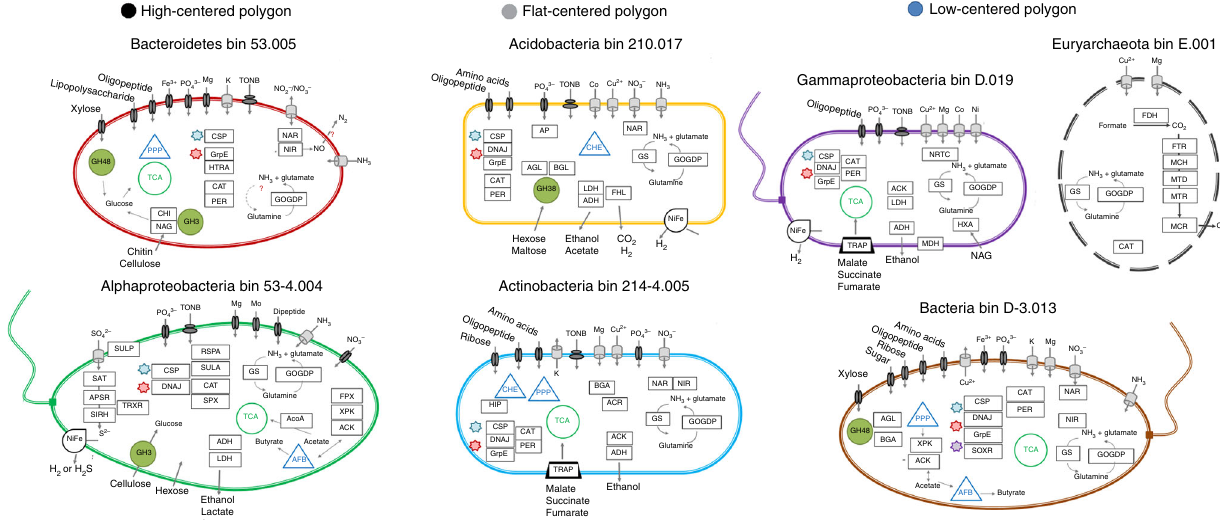
Fig. 5 Barrow genome bins are indicative of metabolic fl exibility and high potential for soil organic matter degradation. Metabolic models with detected genes (box) show a wide variety of functions in Barrow bins. Cell morphology is arbitrarily displayed. Pathways; PPP: pentose phosphate pathway, TCA: citric acid cycle, GG: glycolysis – glyconeogenesis, AFB: acetyl-CoA fermentation to butyrate, CHE: bacterial chemotaxis, TONB: ferric siderophore transport system. CAZymes; GH3: glycoside hydrolase family 3, GH38: glycoside hydrolase family 38, GH48: glycoside hydrolase family 48. Methanogenesis; FDH: formate dehydrogenase (EC 1.2.1.2), FTR: formylmethanofuran--tetrahydromethanopterin N-formyltransferase (EC: 2.3.1.101), MCH: methenyltetrahydromethanopterin cyclohydrolase (EC: 3.5.4.27), MTD: methylenetetrahydromethanopterin dehydrogenase (EC:1.5.98.1), MCR: methyl- coenzyme M reductase (EC:2.8.4.1), MTR: tetrahydromethanopterin S-methyltransferase (EC:2.1.1.86). Stress Response; CSP: cold shock protein, DNAJ: heat shock protein/chaperone protein, GrpE: heat shock protein, SOXR: redox-sensitive transcriptional activator SoxR, RSPA: starvation sensing, SULA: cell division inhibitor, SPX: superoxide dismutase [Fe] (EC 1.15.1.1), HIP: HipA protein, inhibits cell growth and induces persistence, ACR: arsenic resistance protein. Assimilatory sulfate reduction. Genes; SULP: sulfate permease, SAT: sulfate adenylyltransferase (EC 2.7.7.4), APSR: adenylyl-sulfate reductase [thioredoxin] (EC 1.8.4.10), SIRH: sul fi te reductase [NADPH] (EC 1.8.1.2), TRXR: thioredoxin reductase (EC 1.8.1.9), PER: peroxidase (EC 1.11.1.7), CAT: catalase (EC 1.11.1.6), HTRA: protease, RUB: rubrerythrin, CYC-c551: cytochrome c551 peroxidase (EC 1.11.1.5), FPX: fructose-6-phosphate phosphoketolase (EC 4.1.2.22), XPK: xylulose-5-phosphate phosphoketolase (EC 4.1.2.9), ACK: acetate kinase (EC 2.7.2.1), ACS: acetyl-CoA synthetase (EC 6.2.1.1), NAR: assimilatory nitrate reductase (EC 1.7.99.4), NIR: ferredoxin nitrite reductase (EC 1.7.7.1), GS: glutamine synthatase (EC 6.3.1.2), GOGDP: glutamate synthetase (EC 1.4.1.13), AGL: alpha-glucosidase (EC 3.2.1.20), BGL: beta-glucosidase (EC 3.2.1.21), BGA: beta-galactosidase (EC 3.2.1.23), AXYL: alpha- xylosidase (EC 3.2.1.-), BXYL: beta-xylosidase (EC 3.2.1.37), CHI: chitinase (EC 3.2.1.14), NAG: beta-N-acetylglucosaminidase (EC: 3.2.1.96), ADH: alcohol FHL: formate hydrogenlyase (EC 1.2.1.2), NRTC: nitrogen regulatory protein C (NtrC), HXA: hexosaminidase (EC